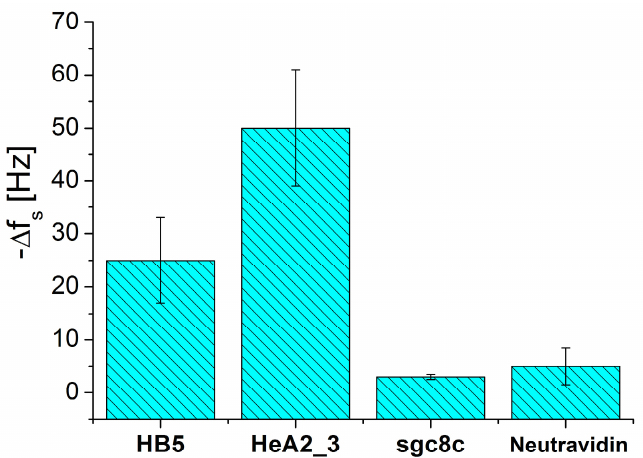
Figure 5. Changes of the resonant frequency for aptasensors formed by HB5, HeA2_3, sgc8c aptamers and without aptamer (only neutravidin layer was presented) following interaction with HER2 positive SK-BR-3 cells (5 × 10 4 cells/mL). Results are mean ± SD obtained from 3 independent experiments in each series.